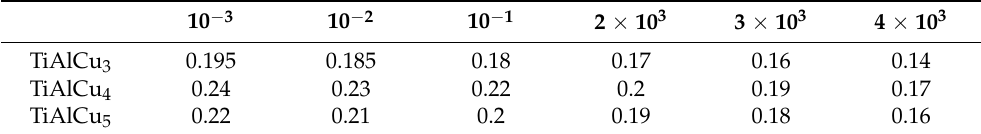
Figure 3. Stress − strain curves of TiAl 46 Cu x specimens under dynamic strain rates: ( a ) TiAl 46 Cu 3 ; ( b ) TiAl 46 Cu 4 ; and ( c ) TiAl 46 Cu 5 . Table 1. The fracture strain for all tested specimens under different strain